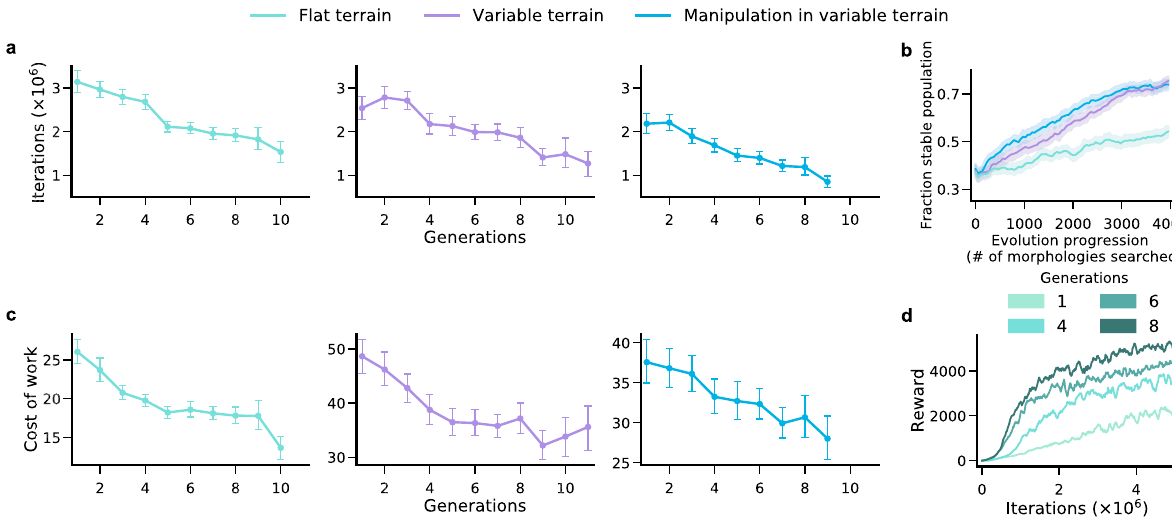
Fig. 4 A morphological Baldwin effect and its relationship to energy ef fi ciency and stability. a Progression of mean ( n = 100) iterations to achieve the 75th percentile fi tness of the initial population for the lineages of the best 100 agents in the fi nal population across 3 evolutionary runs. b Fraction of stable morphologies (see “ Methods ” ) averaged over 3 evolutionary runs per environment. This fraction is higher in VT and MVT than FT, indicating that these more complex environments yield an added selection pressure for stability. c Mean cost of work (see “ Methods ” ) for same lineages as in ( a ). d Learning curves for different generations of an illustrative agent evolved in FT indicate that later generations not only perform better but also learn faster. Thus overall evolution simultaneously discovers morphologies that are more energy ef fi cient ( c ), stable ( b ), and simplify control, leading to faster learning ( a ). Error bars ( a , c ) and shaded region ( b ) denote 95% bootstrapped con fi dence